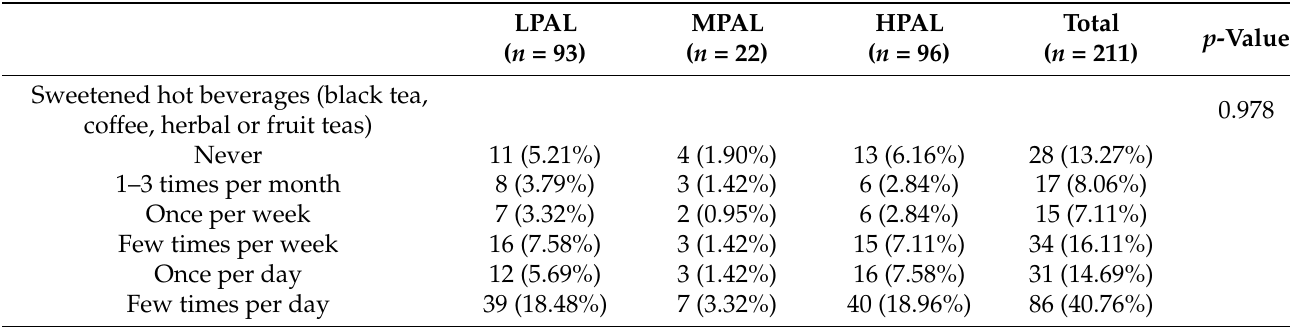
Table 3. Consumption frequency of selected food by physical activity